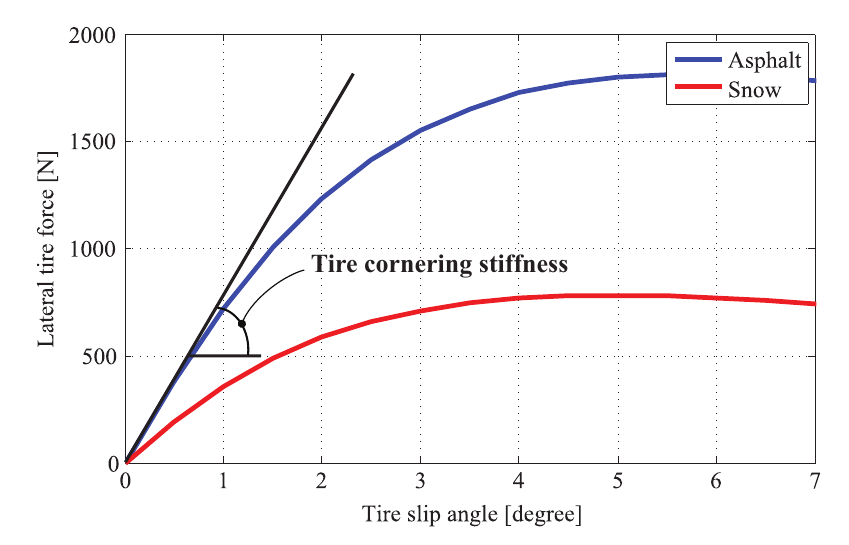
Figure 4. Relation between tire slip angle and lateral tire